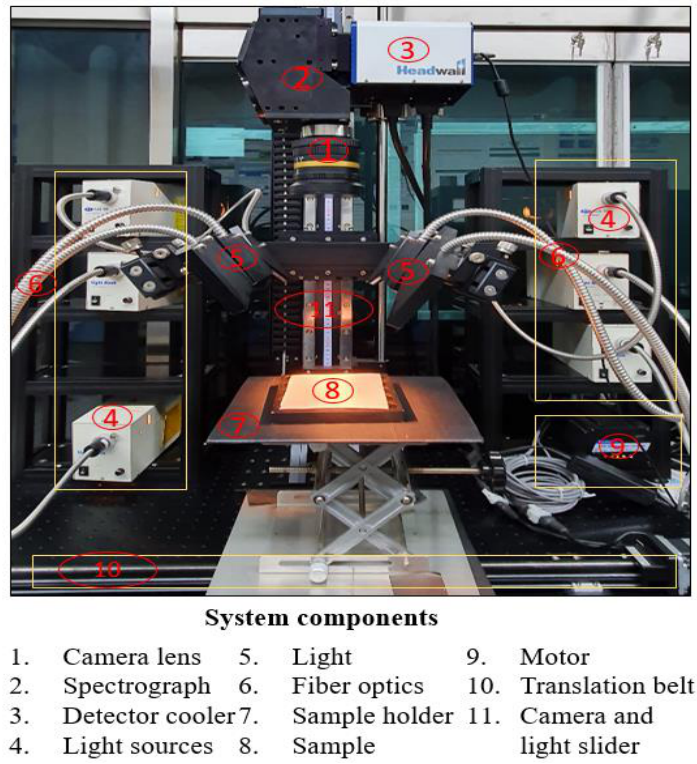
Figure 1. Hyperspectral imaging system and major components.